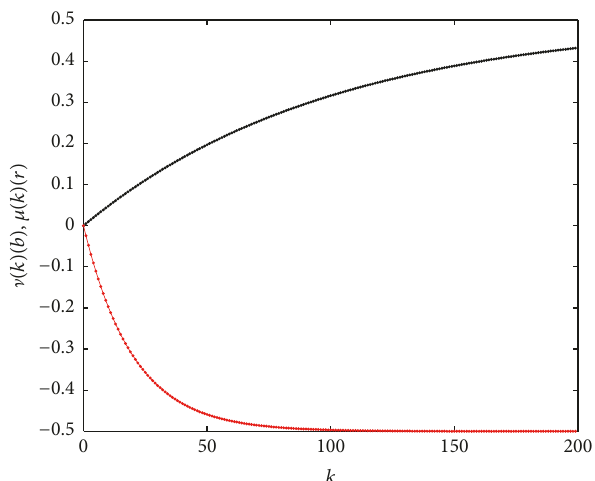
Figure 1: Plots of order functions defined by formula (32).